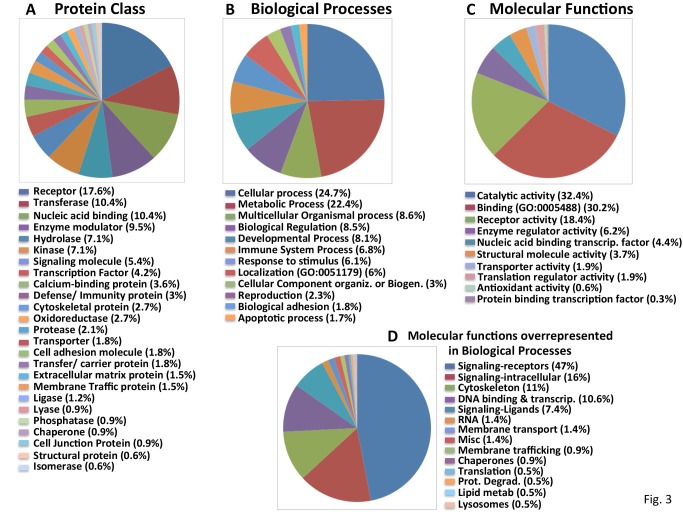
Classification of the “Confirmed S6-P positives” into functional groups.Categorization of “Confirmed S6-P positives” using the PANTHER classification system into A. Protein Class; B. Molecular Function; C. Biological Processes. D. Manual reclassification by molecular function of the non-redundant “Confirmed S6-P positives” (listed in Supp Table 7) comprising the subcategories of “Biological Processes overrepresented in comparison to the whole genome (shown in S1 Fig.).”